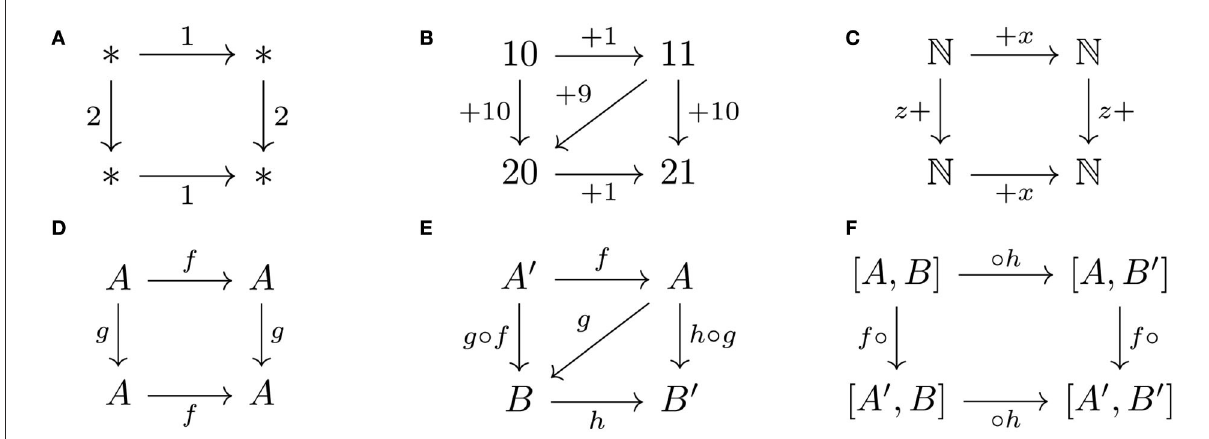
FIGURE4 Commutativity and associativity properties are expressed as commutative squares: (A) commutativity of addition, (B,C) associativity of addition, (D) commutative composition operation, and (E,F) associativity of composition